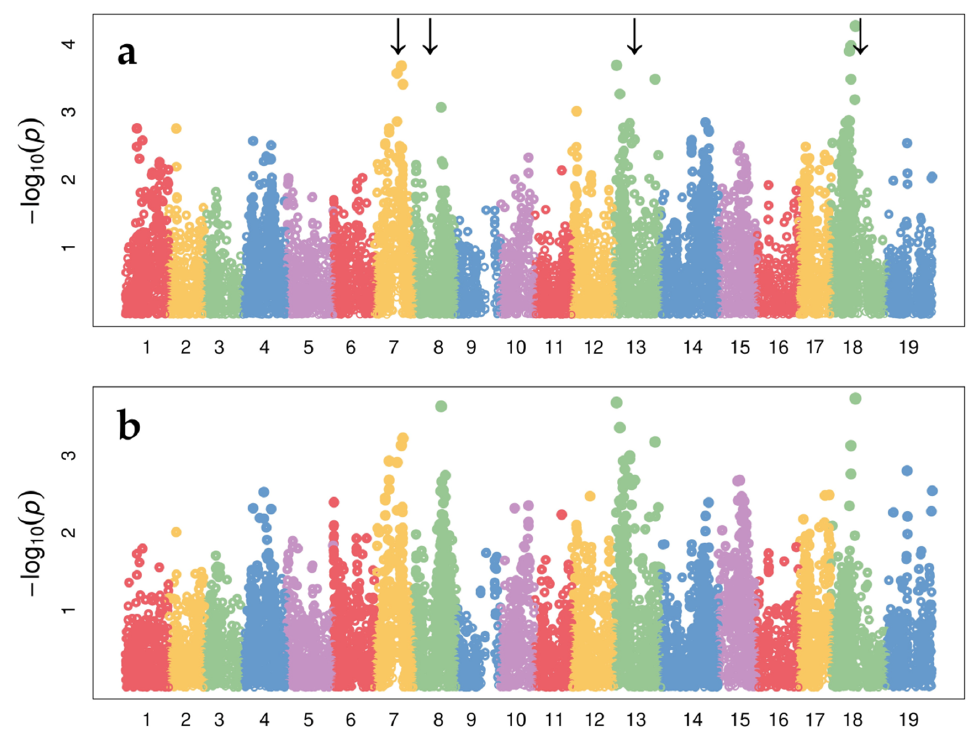
Figure 3. The Manhattan plot that summarizes GWAS results obtained from GLM ( a ) and MLM ( b ) for the trait ‘intensity of phylloxera gall formation’ (R, %). The x -axis is the genomic position of the SNPs, and the y -axis is the negative log base 10 of the p -values. Each chromosome is colored differ- ently. Loci with the strongest associations with the trait on chromosomes 7, 8, 13, and 18 are marked by arrows.